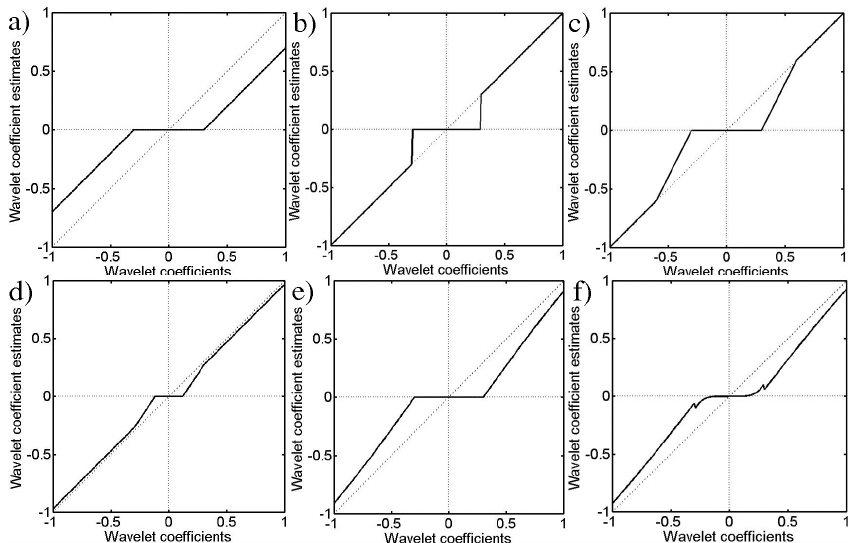
Figure 2. Threshold functions to estimate the wavelet coefficients: ( a ) soft threshold (ST); ( b ) hard threshold (HT); ( c ) half-soft threshold (HST); ( d ) improved semi-soft and half-soft threshold (ISHST); ( e ) improved soft and hard threshold (ISHT); and ( f ) improved threshold based on the ST and the ISHT (ISIT).